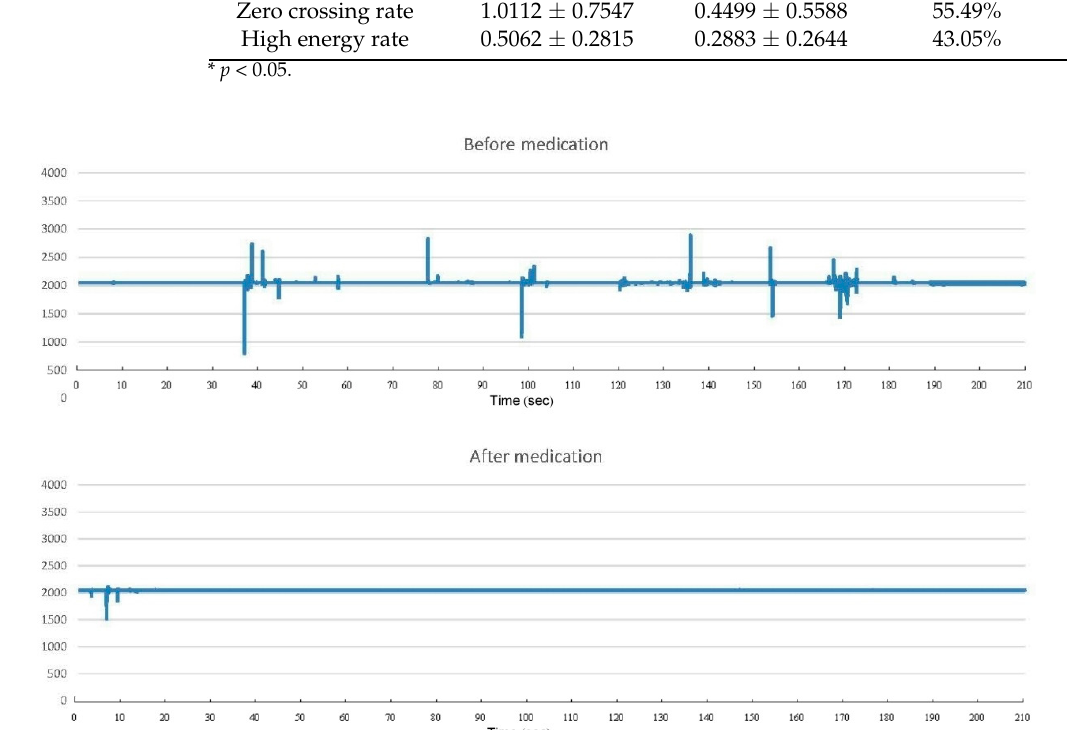
Figure 3. An example of measurements from one patient before and after 1 month of methylphenidate treatment.